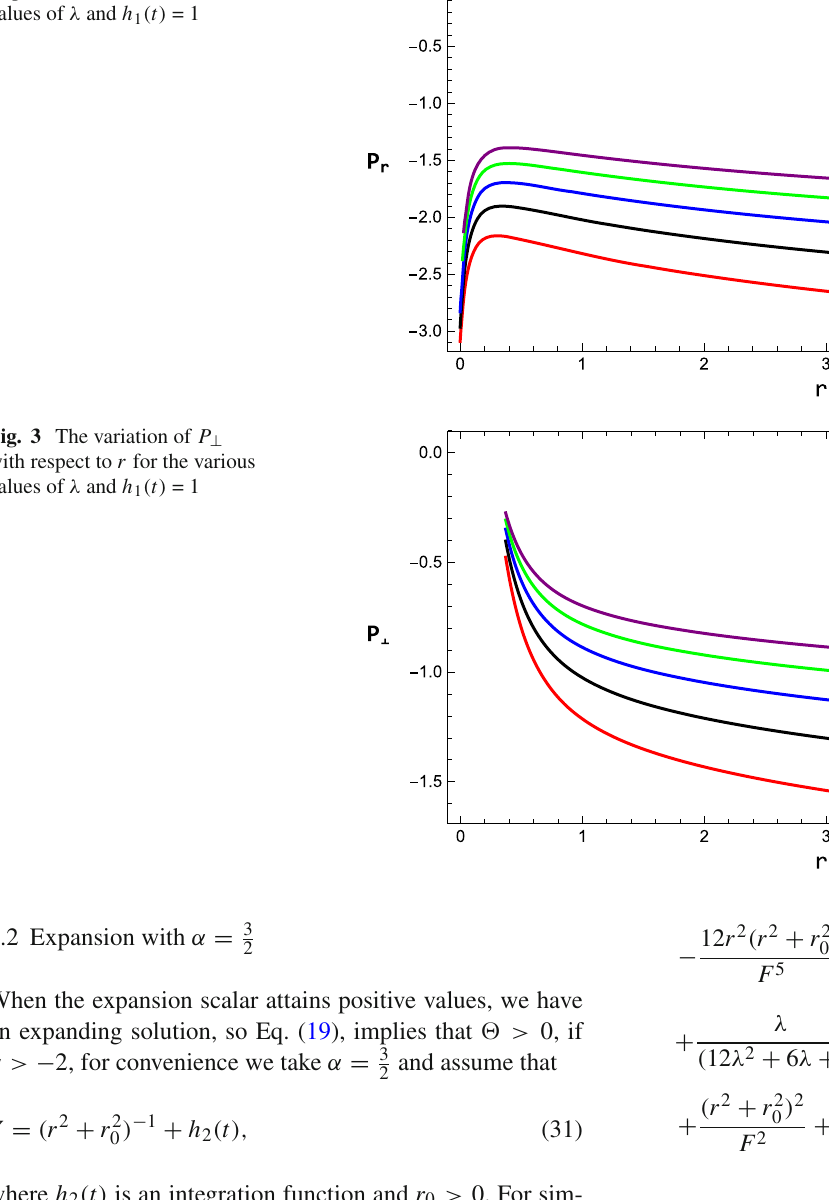
Fig. 2 The variation of P r with respect to r for the various values of λ and h 1 ( t ) = 1